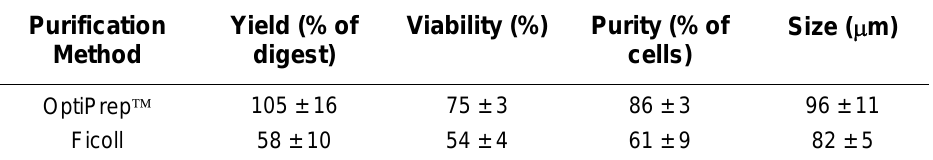
Comparison of Islet Purification Methods Following Collagenase Digestion of Juvenile Porcine Pancreases Purification Yield (% of Method